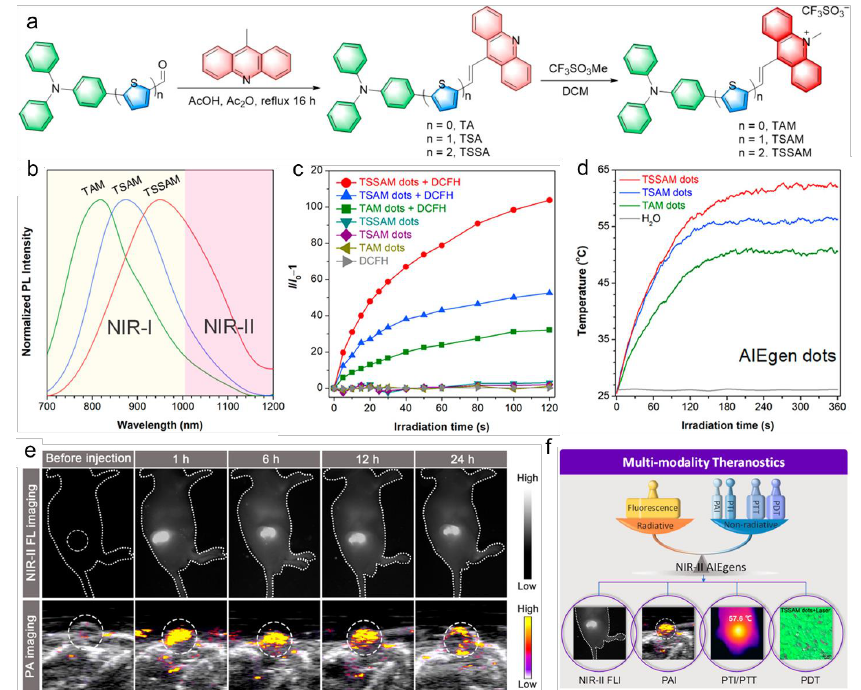
Figure 2. ( a ) Synthesis and chemical structures of TAM, TSAM, and TSSAM; ( b ) PL spectra; ( c ) ROS generation using dichlorofluorescin diacetate (DCFH-DA); and ( d ) photothermal curves of different AIEgens under the irradiation of 660 nm laser. ( e ) In vivo NIR-II fluorescence and PA imaging of 4T1 tumor-bearing mice at different time points after intravenous injection. ( f ) Schematic illustration of various diagnostic and therapeutic modalities in one molecule (Reprinted with permission from Ref. [92]. Copyright 2020, American Chemical Society). Molecules 2022 , 27 , 6649 Almost at the same time, Tang and Wang et al., reported a powerful AIEgen with all the phototheranostic modalities, including NIR-II fluorescence, PA and photothermal im- aging, PDT and PTT treatments (Figure 3) [93]. They designed three compounds (TI, TSI, and TSSI) consisting of 1,3-bis(dicyanomethylene) indole as the A unit, TPA as the D unit, and a thiophene segment as both π -bridge and electron donor. The thiophene spacer in TSI and TSSI resulted in a significant red shift of the absorption/emission wavelength; and the gradually increased D – A intensity in TI, TSI, and TSSI also significantly enhanced the ROS production and photothermal conversion. As a result, TSSI NPs exhibited the reddest photoluminescence (PL) wavelength, best PDT property, and highest PCE (46%). The en- capsulated TSSI NPs could be internalized into lysosomes in 4T1 cancer cells, which ex- hibited excellent anti-tumor properties under 660 nm laser irradiation. Inspired by the multifunctional phototheranostic properties, the in vivo biomedical applications of TSSI NPs were carried out in 4T1 tumor-bearing BALB/c nude mice. The NIR-II fluorescence imaging helped to visualize the tumor site sensitively, which was also confirmed by the PA signal and photothermal imaging. Subsequently, the in vivo tumor killing activity of TSSI NPs was verified, and the tumor was effectively eradicated with only one injection and one-time light irradiation without recurrence. In comparison with the traditional “ all- in-one ” strategy, this “ one-for-all ” agent based on an AIEgen achieves multifunctional phototheranostics in the more direct manner and maximizes the efficacy of light therapy.